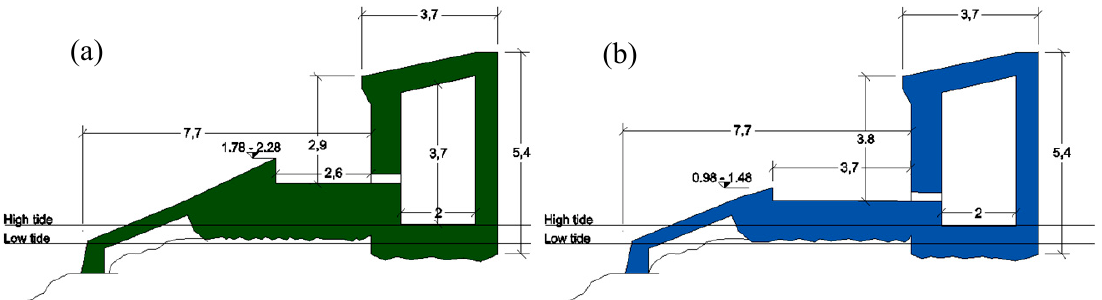
Figure 14. The cross sections of the OBREC prototype installed in the Naples harbor: ( a ) the RS-LAB (Real Scale Laboratory) configuration and ( b ) the NW-LAB (Natural Waves Laboratory) configuration.